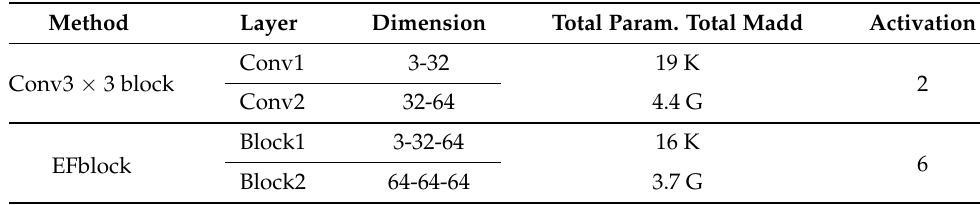
Table 1. Comparing EFblock and standard convolution layers from parameter and calculation number, and number of activation functions. Method Layer Dimension Total Param. Total Madd